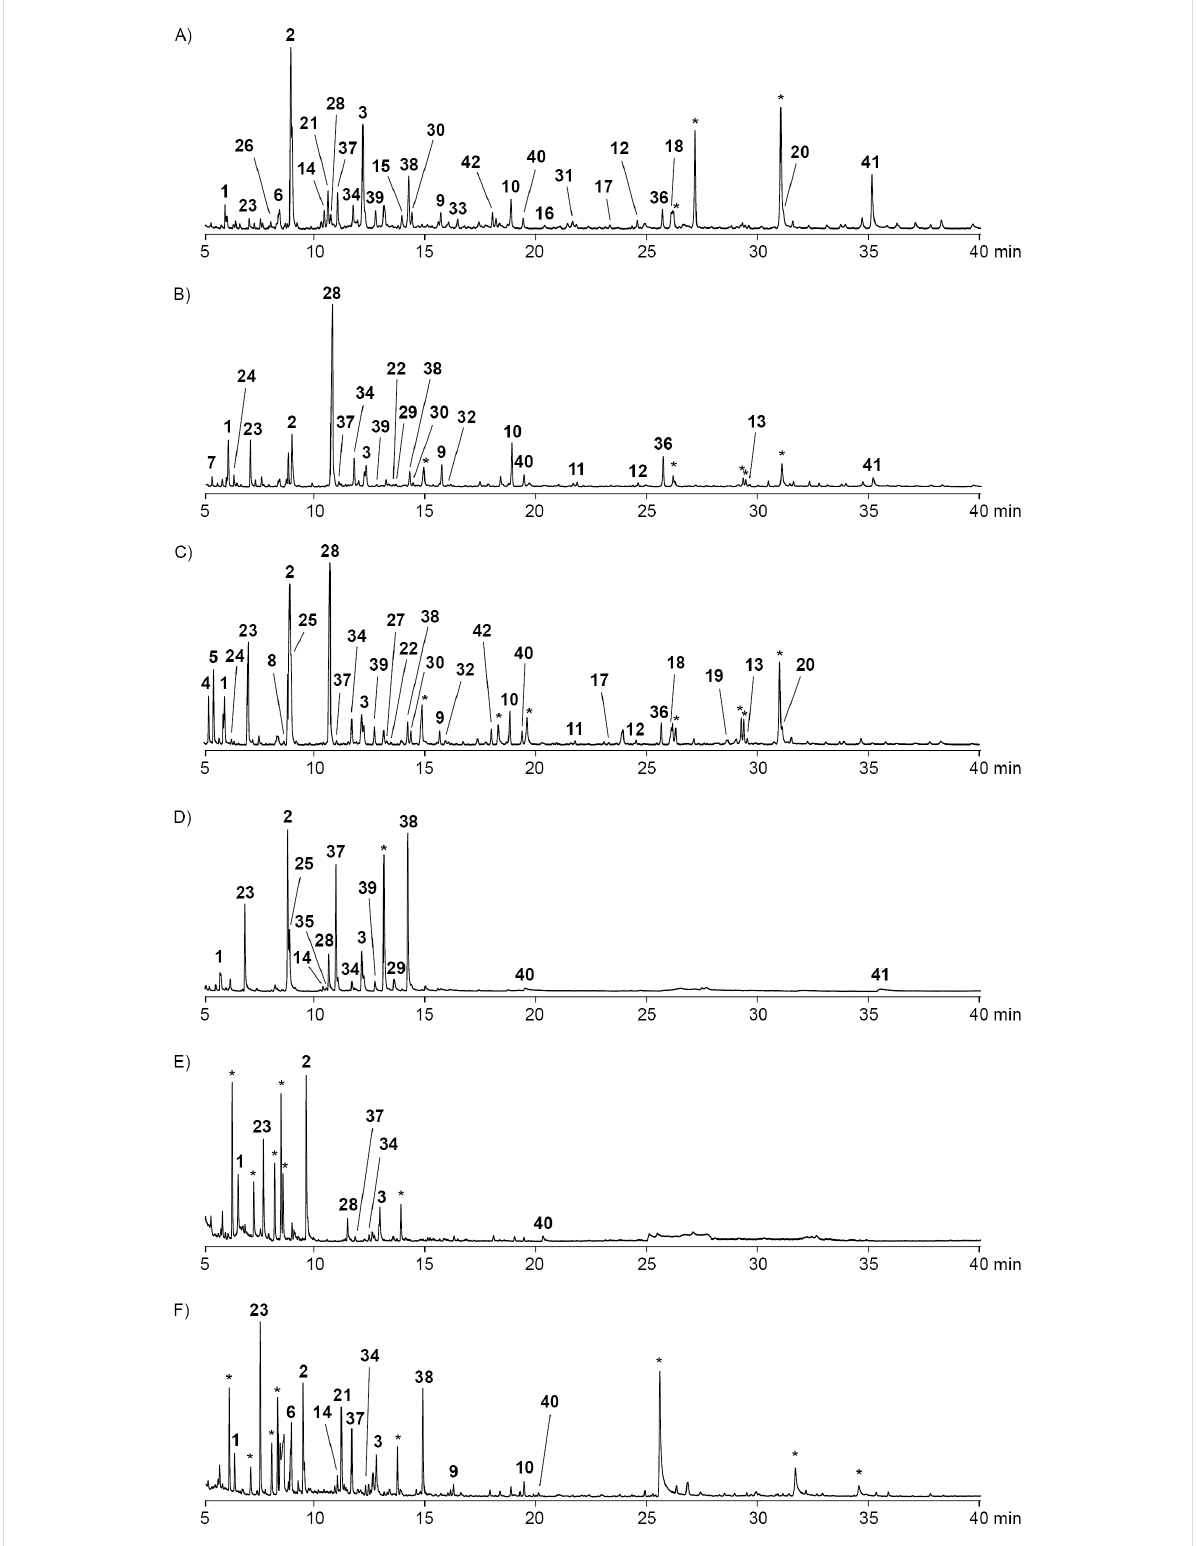
Figure 1: Total ion chromatograms of headspace extracts from A) C. marinus DSM 100036 T , B) C. neptunius DSM 26471 T , C) C. manganoxidans DSM 27541 T , D) C. baekdonensis DSM 27375 T , E) C. halophilus DSM 26270 T , and F) C. indicus DSM 27257 T . Peaks arising from known contami- nants are indicated by